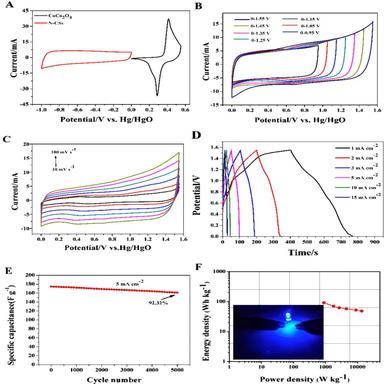
(A) CV curves of the CuCo2O4/NF and N-CCs/NF electrodes at a scan rate of 20 mV s1 in a three-electrode cell; (B) CV curves of the CuCo2O4/NF//N-CCs operated at varied potential window with a scan speed of 100 mV s1 . (C) CV curves of the CuCo2O4/NF//N-CCs at various scan speeds; (D) GCD curves the CuCo2O4/NF//N-CCs at various current densities; (E) Cycling performance the CuCo2O4/NF//N-CCs at 5 mA cm2 ; (F) Ragone plot of the CuCo2O4/NF//N-CCs , the inset shows the blue LED lighted by two devices. (For int